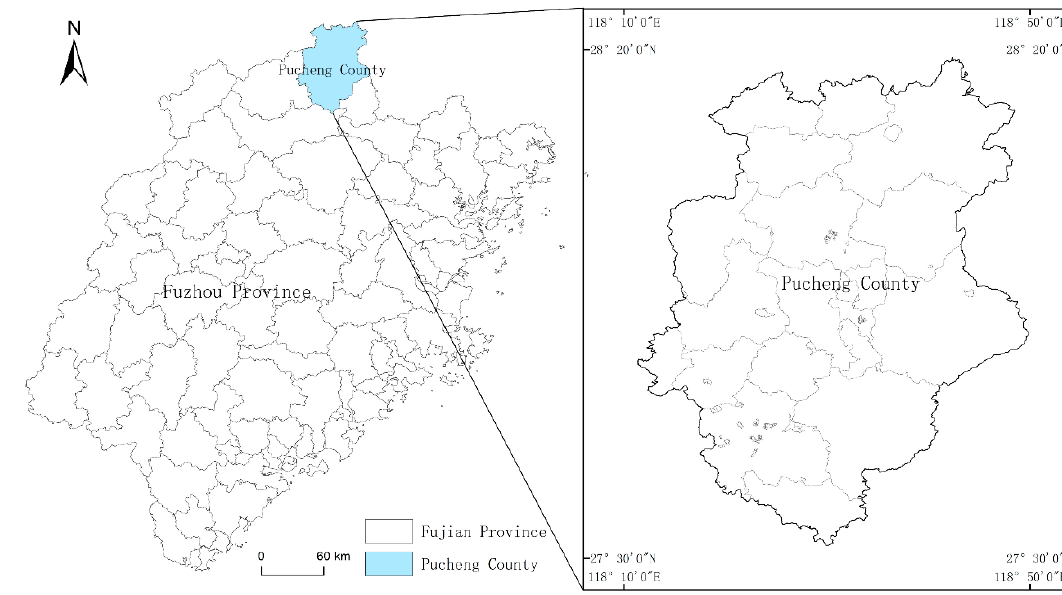
Figure 1. Location of the study area.